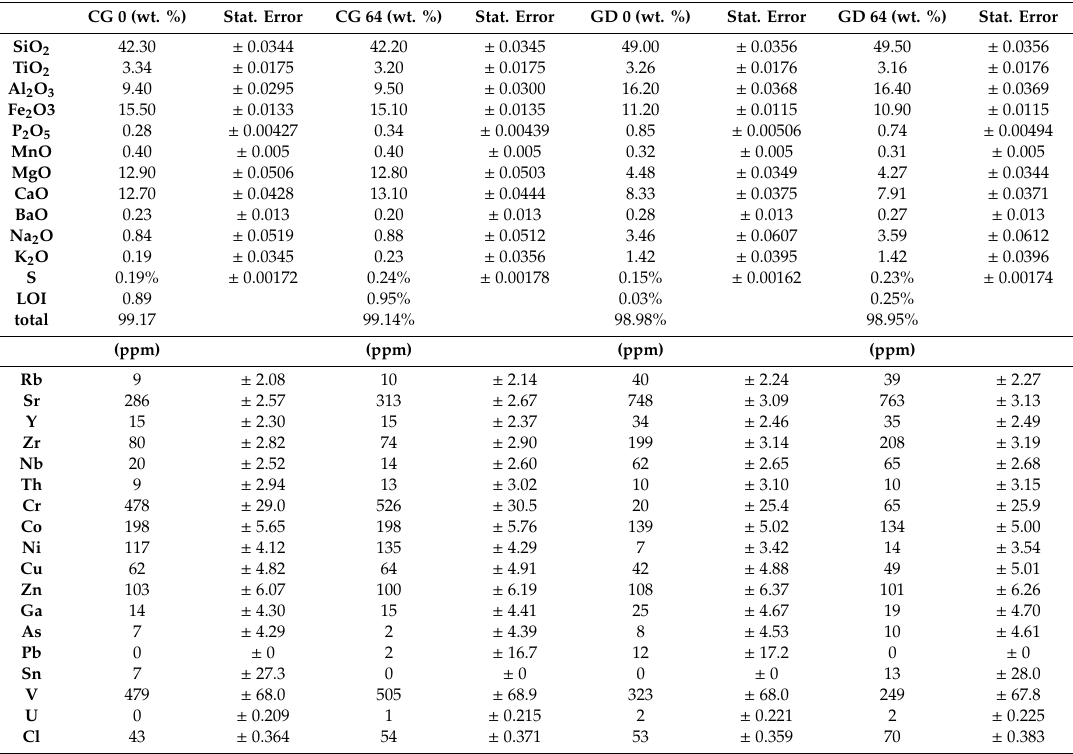
Figure 6. ( a ) Backscattered electron image of a detail of carbon ‐ rich particles (om—organic matter) associated with halite (hal); ( b ) ATR ‐ FTIR spectra of gabbro ‐ diorite (GD) at 0 days (blue) and 16 days (pink). The calcite reference spectrum is also shown for comparison (yellow; STJapan Inc. database). The insets are the spots of analysis. Table 5. Whole-rock geochemistry before and after runs of 64 days for cumulate gabbro (CG) and gabbro-diorite (GD). CG 0 (wt. %)